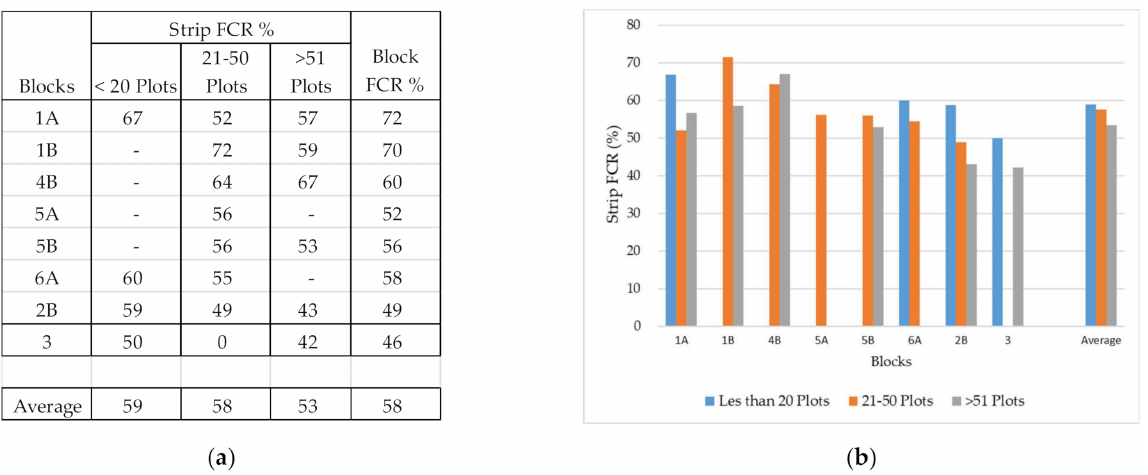
Figure 9. FCR length of various strip lengths ( a ) and graph of FCR at different strip lengths ( b ).